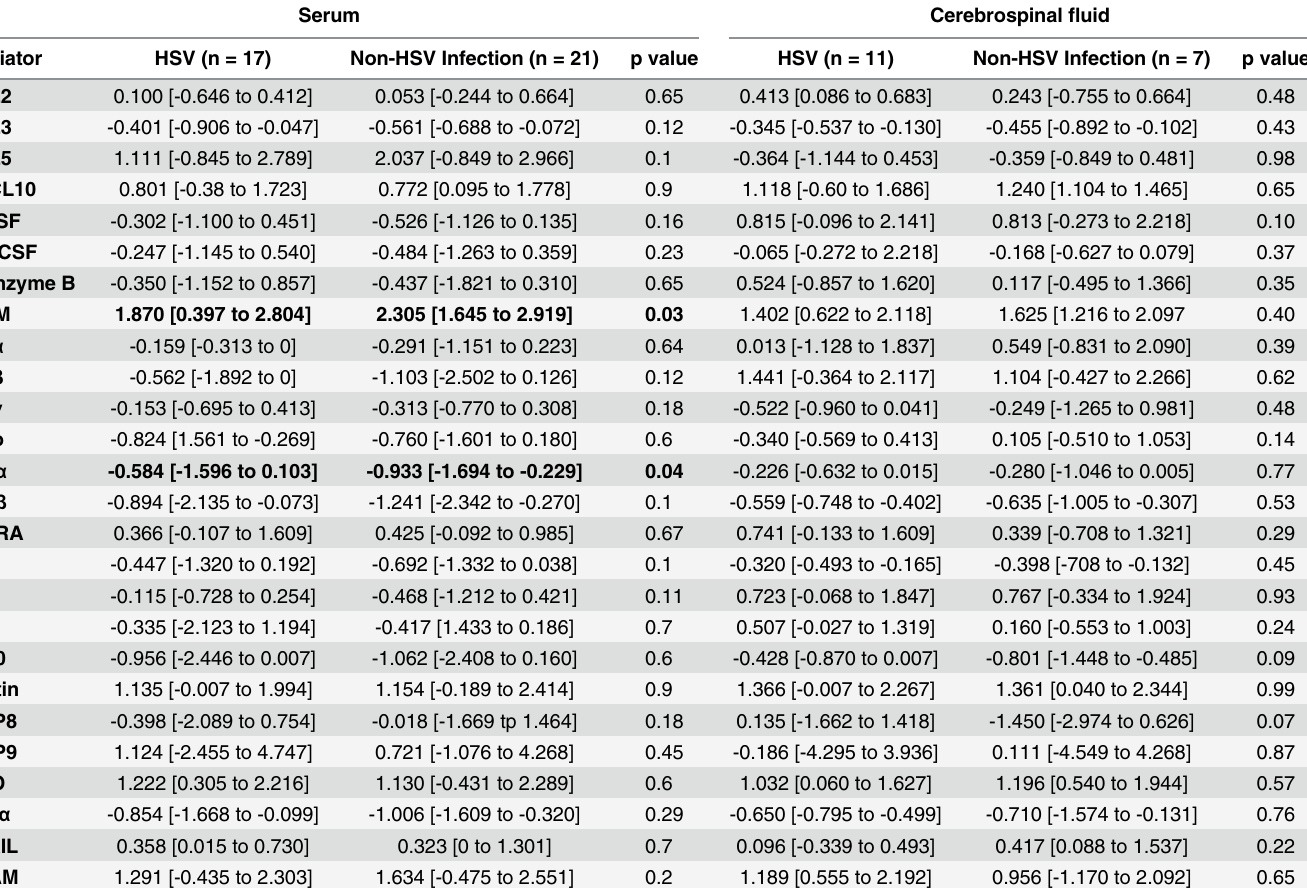
Table 5. Comparison between the median mediator concentrations in serum and CSF in patients with HSV encephalitis and the rest of the group with encephalitis of an infectious